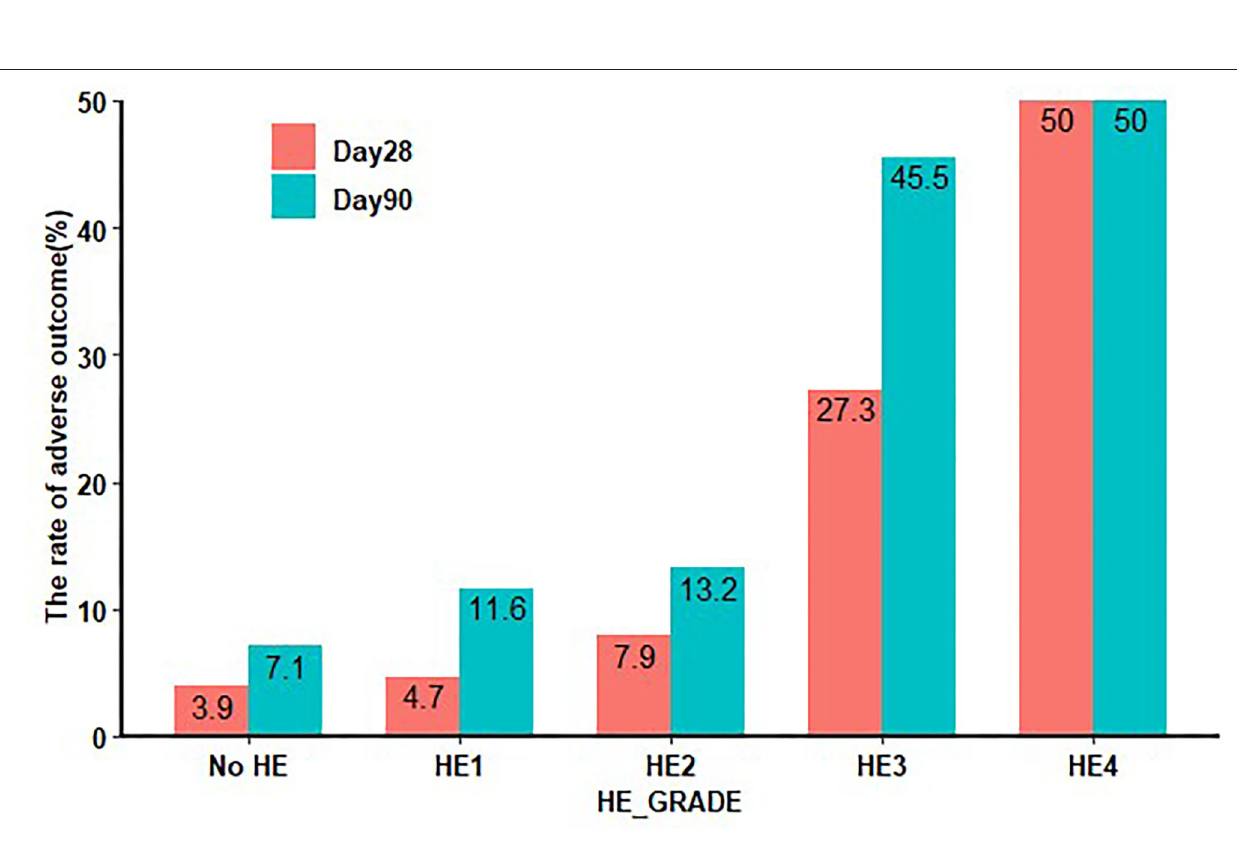
Frontiers in Medicine |